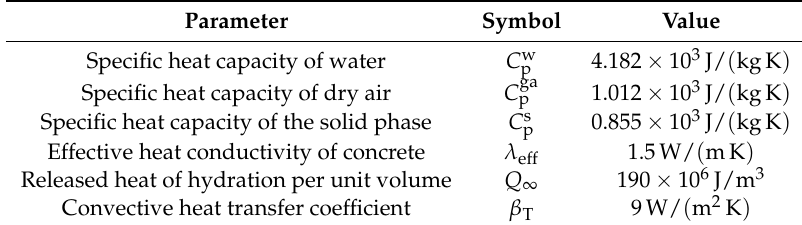
Table 6. Parameters for the enthalpy balance